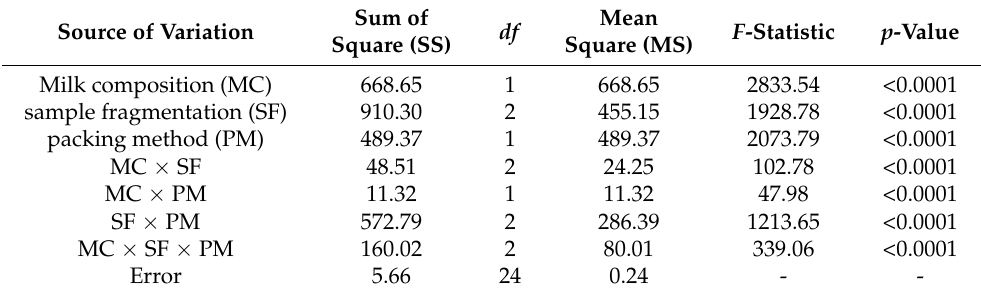
Table 5. Three-factorial analysis of variance for the amount of water–fat serum released from fresh pasta filata cheese made from cow’s milk and its mixture with sheep’s milk obtained within 24 h after unpacking.